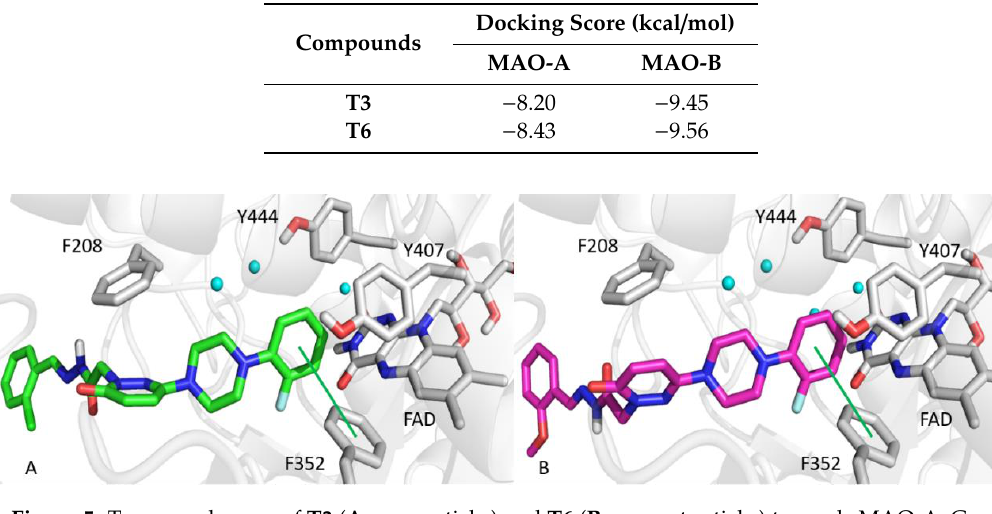
Figure 6. Top scored poses of T3 ( A , green sticks) and T6 ( B , magenta sticks) towards MAO-B. Red arrows indicate hydrogen bonds. Water molecules are rendered as cyan spheres. Computational studies of T3 or T6 interactions with MAO-A or MAO-B provided satisfactory explanations for the experimental biological data obtained. Docking scores of T3 and T6 agreed with IC 50 experimental values, which indicated T6 is better than T3 . Regarding binding modes, the ortho- fluorine phenyl rings of T3 and T6 face the hydrophobic cages of MAO-A and MAO-B. Interestingly, the main difference between MAO-A and MAO-B interactions centers on the presence of two hydrogen bonds between the hydrazone moieties of T3 and T6 and E84 and T201 of MAO-B, due to no hydrogen bond with their corresponding sites V93 and V210 in MAO-A, thus supporting that T3 and T6 are selective MAO-B inhibitors. 2.7. ADME Prediction The physicochemical parameters and likenesses of T3 and T6 were further investigated by BOILED-Egg construction and using the SwissADME online platform. These online programs determine whether compounds are suitable for oral administration based on the bioavailability radar panel containing physicochemical properties such as flexibility, insolubility, lipophilicity, saturation, size, and polarity, and provide rapid appraisals of the drug-likenesses of drug candidates. The BOILED-Egg constructions of T3 and T6 predicted that both are well absorbed in the GI tract but in outside of blood-brain barrier (BBB) permeation range (Figure 7). T3 and T6 were shown to lie within the pink regions (optimal ranges) (Figure 8). Bioavailability radar predicted both compounds had acceptable pharmacokinetics and satisfied drug-likeness rules. These results suggest that T3 and T6 should be considered potential drug candidates.